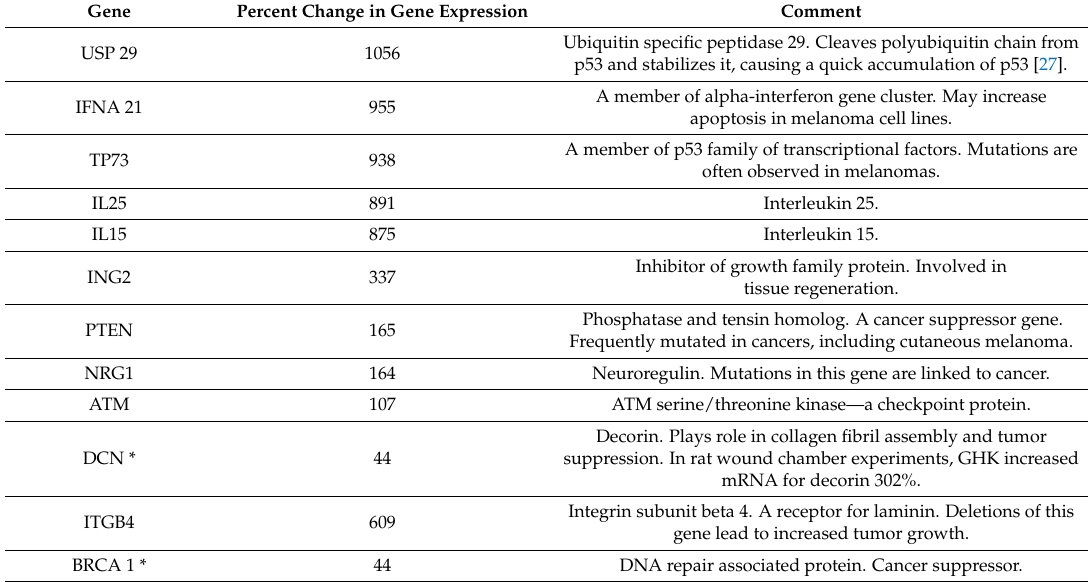
Table 3. GHK and Gene Expression in Cancer Suppressors.